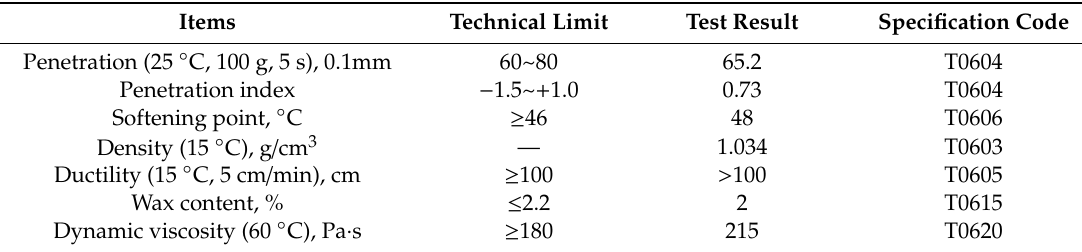
Table 3. Physical properties of 70#A